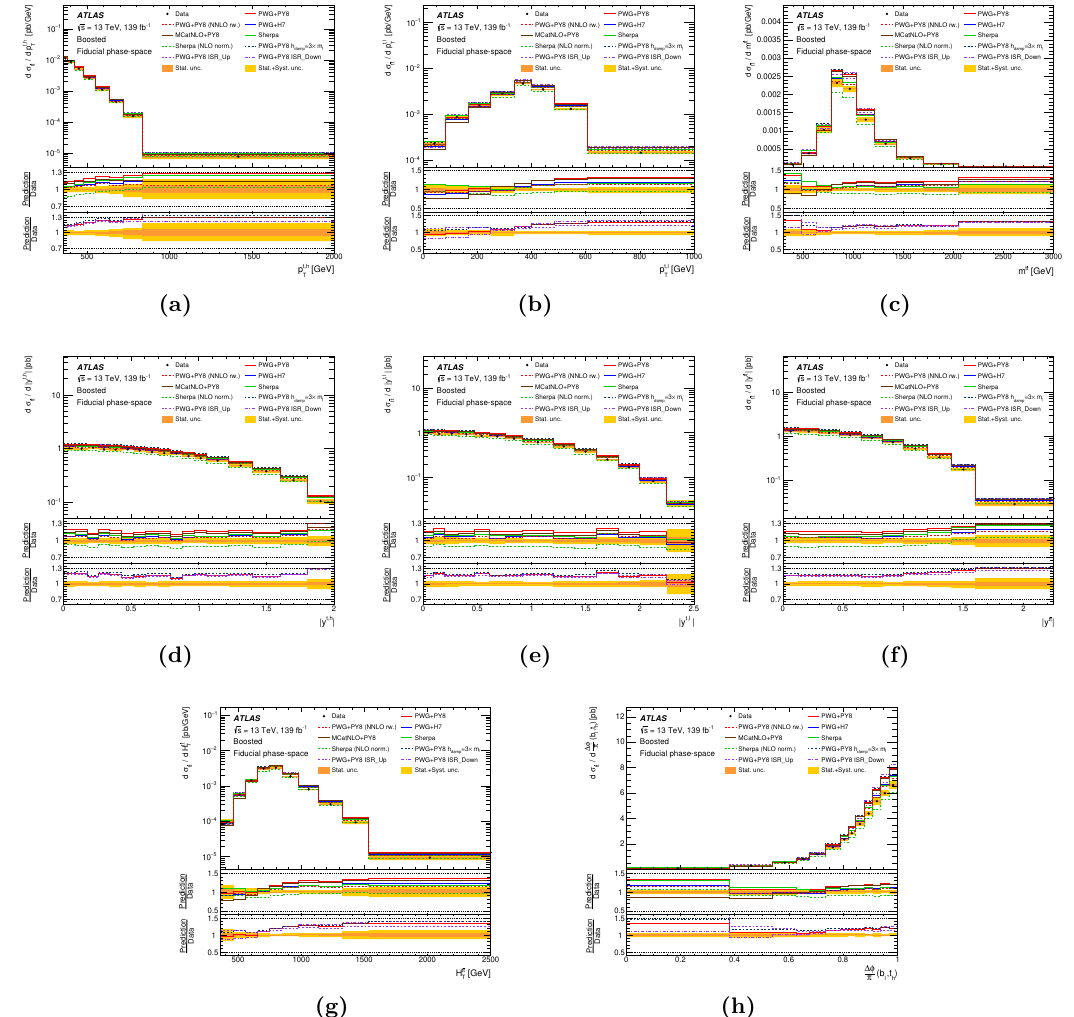
Figure 10. Differential cross-section measurements for the observables related to the kinematics of the top quarks. The cross-section is shown as a function of (a) p t,h , (b) p t,‘ , (c) m t ¯ t , (d) | y t,h | , (e) T T ¯ t ¯ t and (h) ∆ φ ( b ) . In each plot the data are compared with predictions from | y t,‘ | , (f) | y t | , (g) H t , t ‘ h T various MC generators. PWG+PY8 corresponds to the Powheg+Pythia sample, PWG+H7 to the Powheg+Herwig sample and MCatNLO+PY8 to the MadGraph5_aMC@NLO+Pythia sample. The orange band shows the size of the statistical uncertainty and the yellow band shows the size of the total uncertainty. The lower two panels in each subfigure display the ratios of the different predictions to the